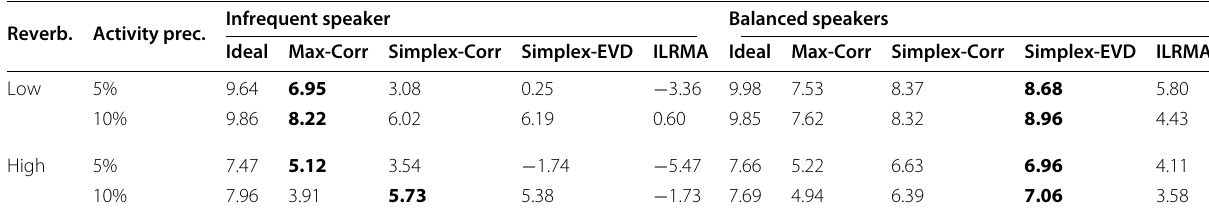
Table 3 Distributed array: SDR scores—mixtures with unbalanced activity for “Low”/“High” reverberation and for “5%”/“10%” activity of the 1st speaker